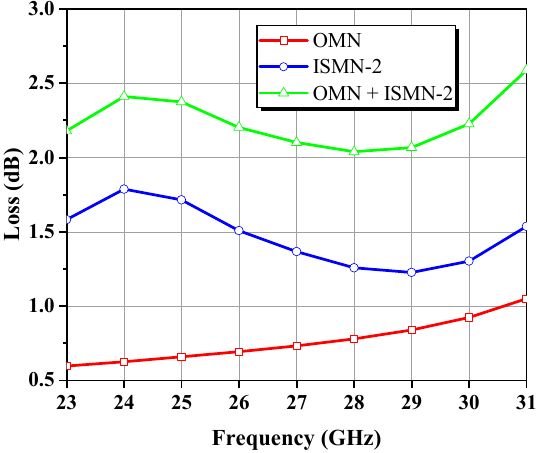
Figure 10. Estimated total losses for the MNs.